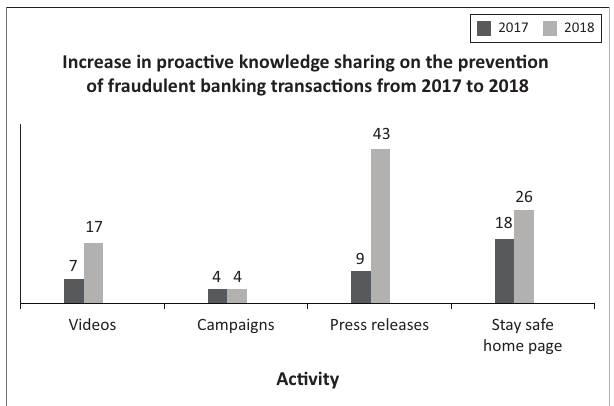
FIGURE 3: Knowledge sharing for e-banking fraud prevention during each time frame.